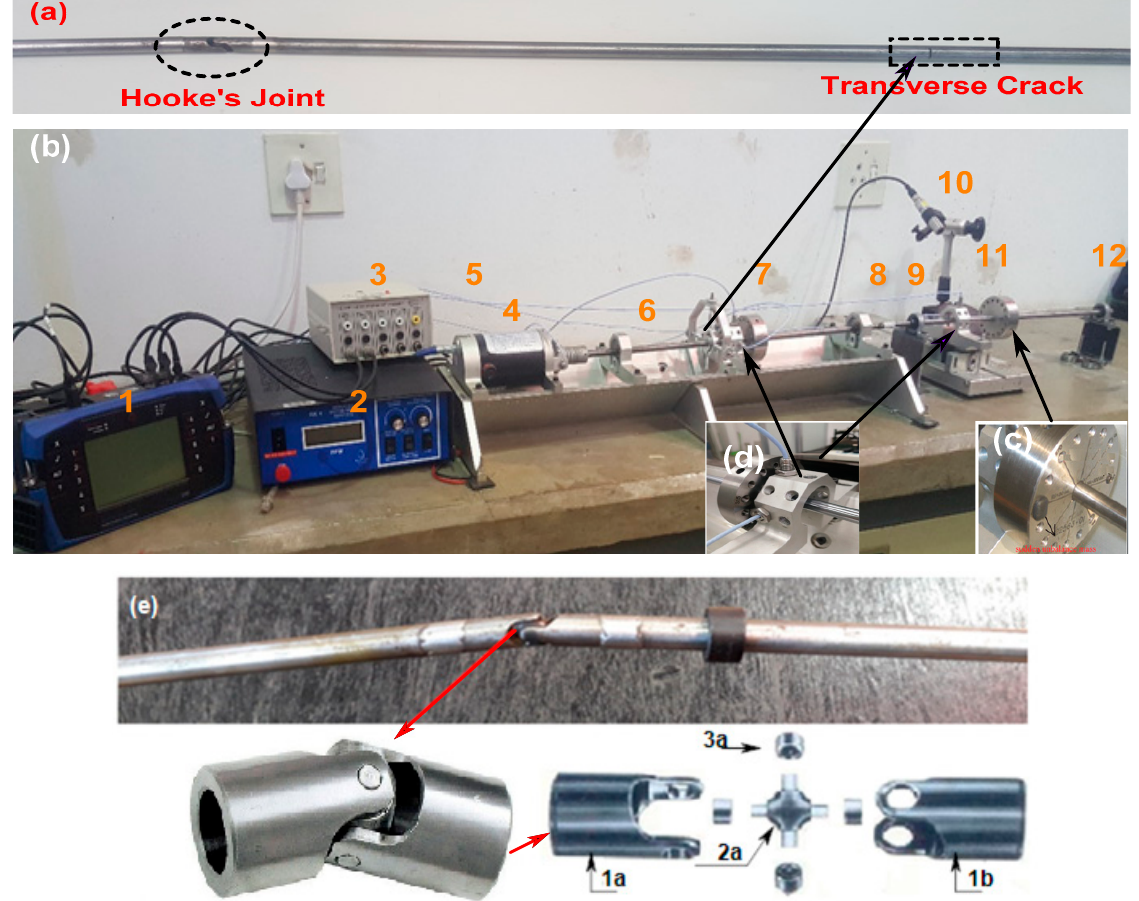
Figure 5. The experimental setup consisting of ( a ) a connected shaft with a crack and Hooke’s joint; ( b – d ) modified Rotor-